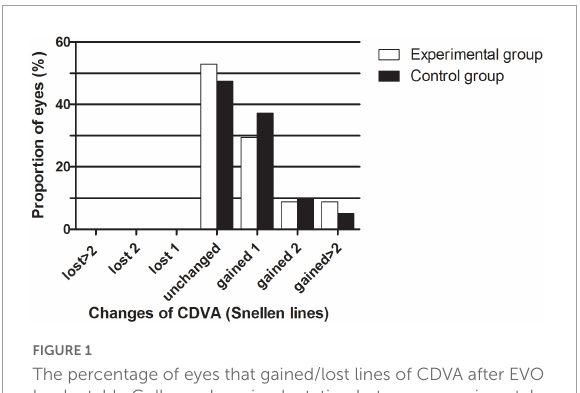
FIGURE1 The percentage of eyes that gained/lost lines of CDVA after EVO Implantable Collamer Lens implantation between experimental and control